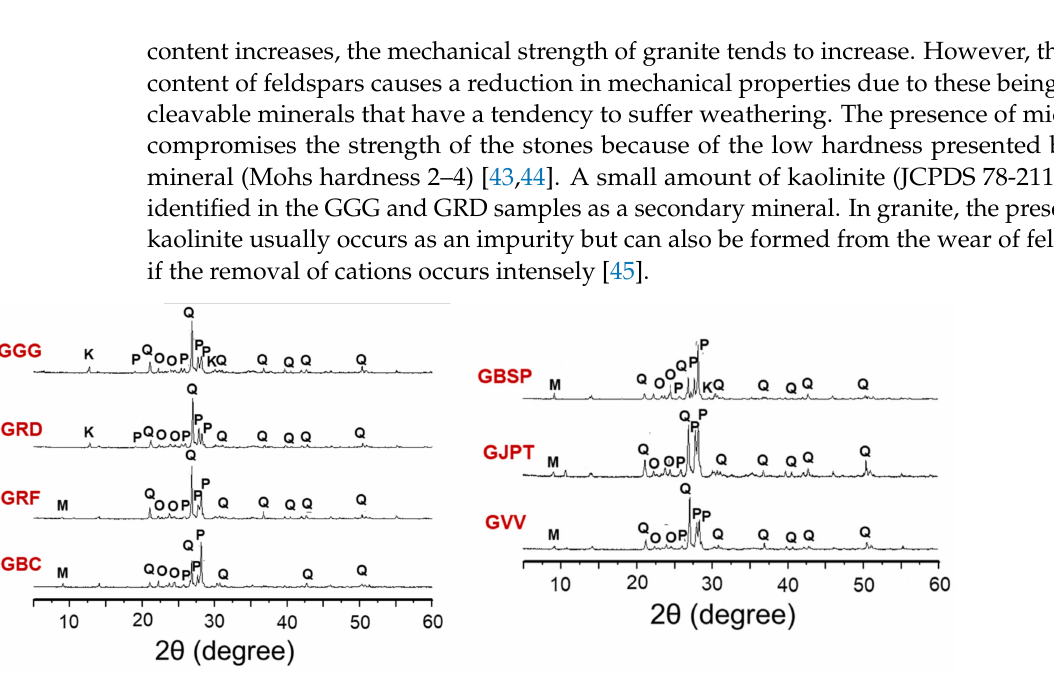
Figure 3. X-ray diffraction patterns of granites. M—mica, K—kaolinite, P—plagioclase, O—orthoclase, and Q—quartz.